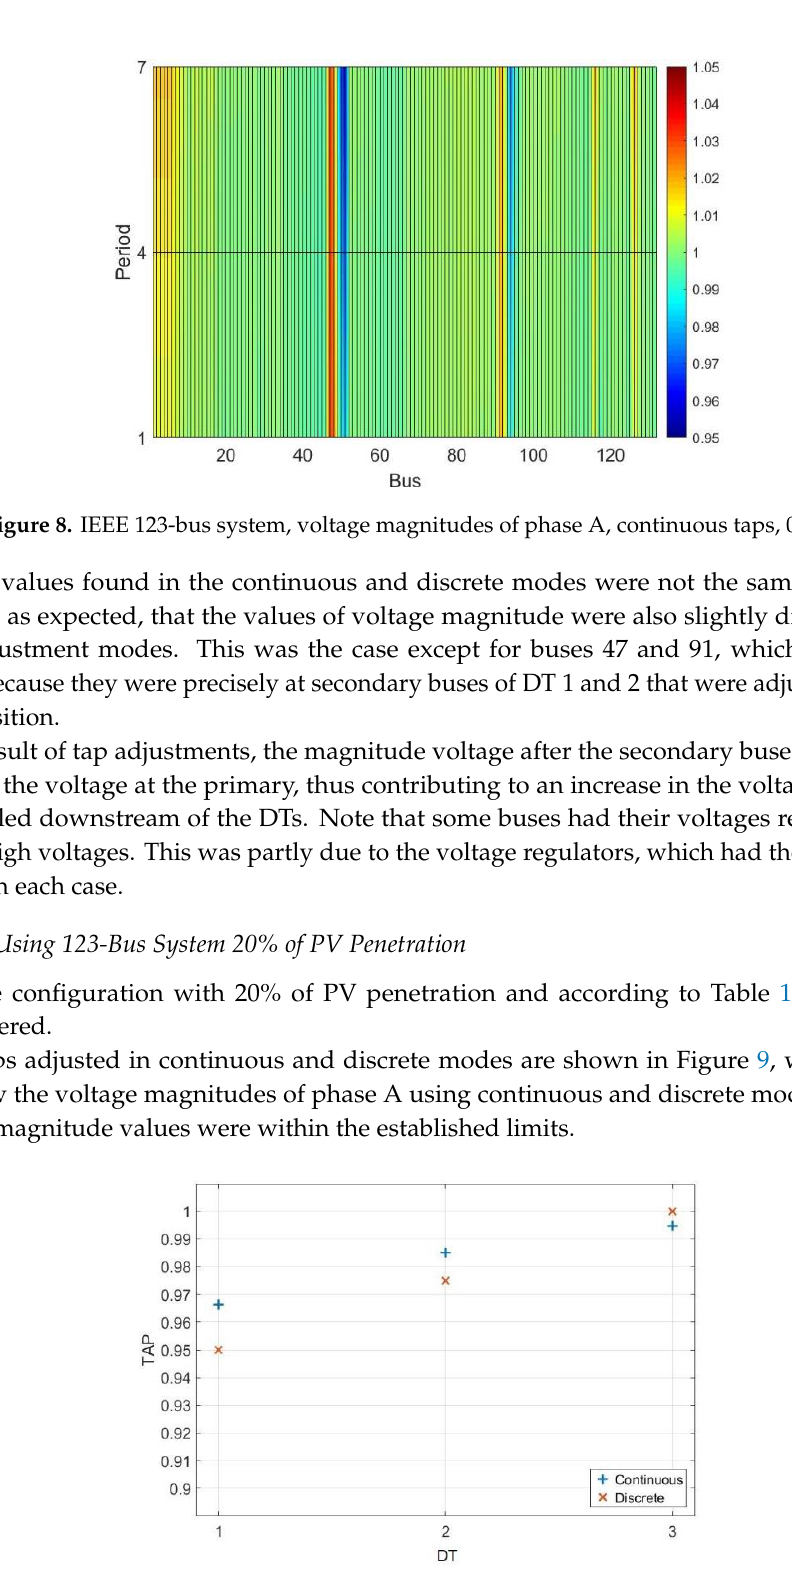
Figure 7. IEEE 123-bus system, voltage magnitudes of phase A, discrete taps, 0% PV.